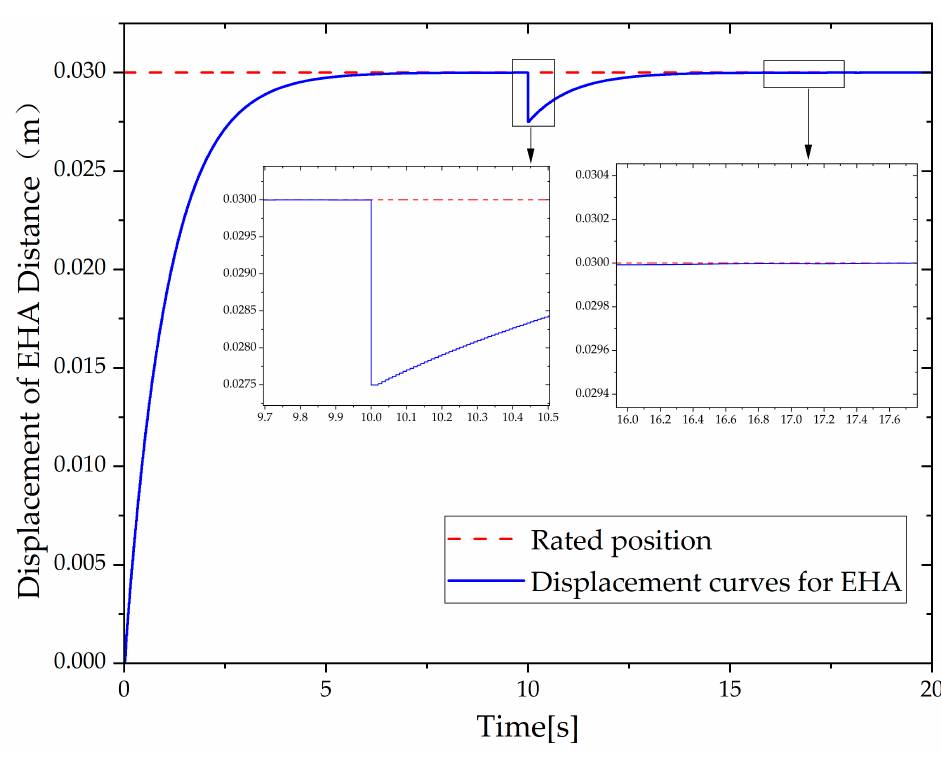
Figure 20. PID control step response curve.